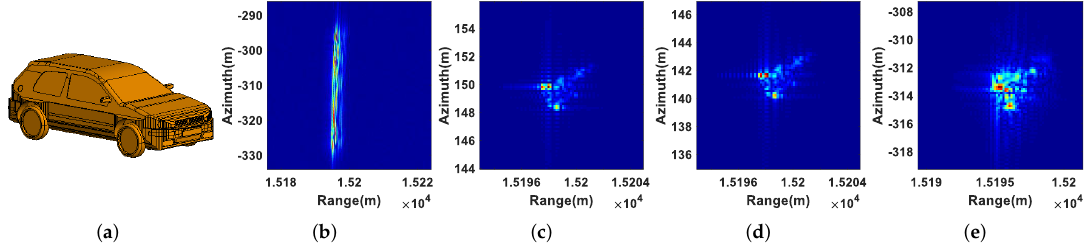
Figure 8. Refocusing results of T4: ( a ) shape of T4; ( b ) defocusing result; ( c ) refocusing result using the real 2D velocity; ( d ) refocusing result using the estimated 2D velocity; ( e ) refocusing result using the PGA algorithm.